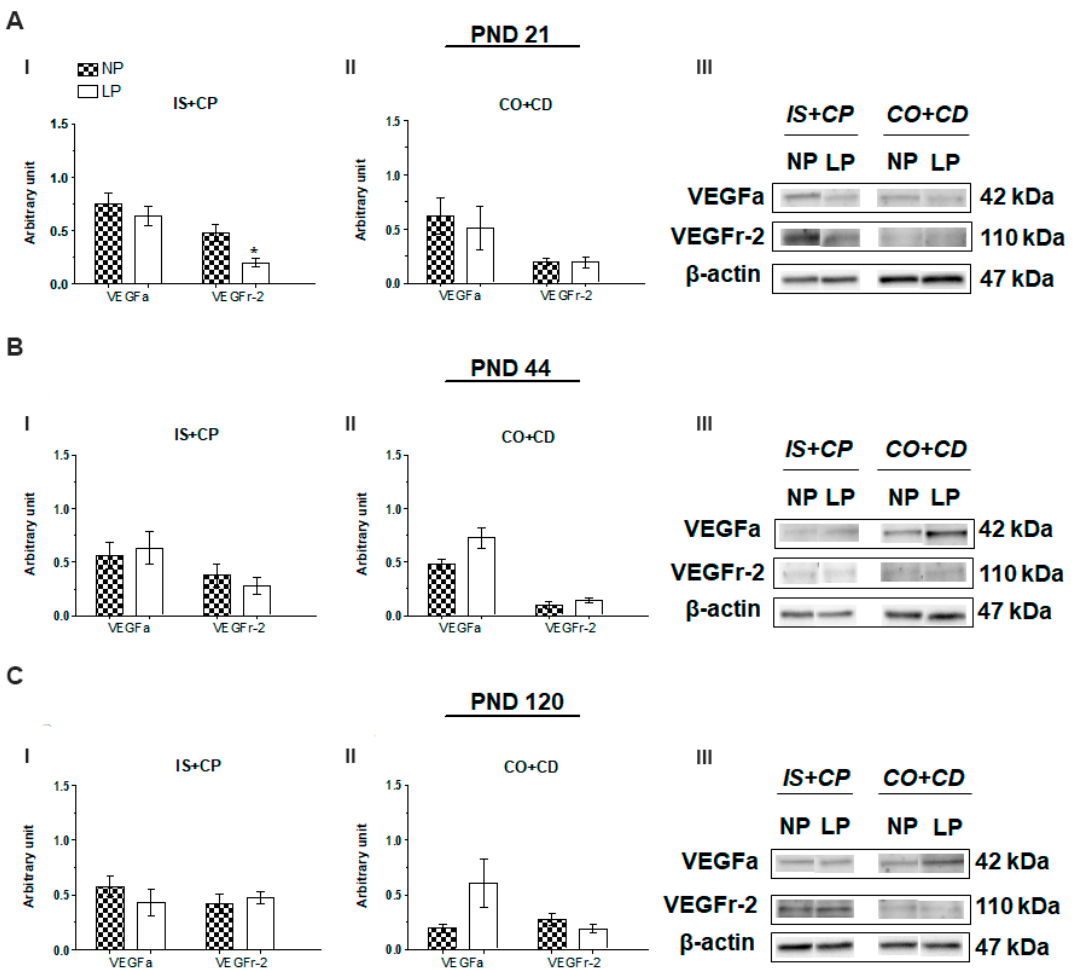
Figure 2. The VEGFa and VEGFr ‐ 2 immunoblots. ( A ) Levels of VEGFa and VEGFr ‐ 2 in the IS+CP (I) and corpus plus cauda (CO+CD) epididymis ( II ) of NP and low ‐ protein (LP) animals on PND 21. Representative blots showing the levels of the VEGF, VEGFr ‐ 2 and β‐ actin proteins (70 μ g of protein) in 21 ‐ day animals ( III ). ( B ) Levels of VEGFa and VEGFr ‐ 2 in the IS+CP ( I ) and CO+CD